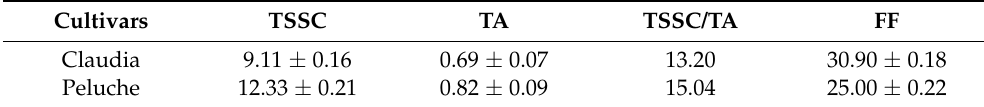
Table 2. Values of TSSC (total soluble solids content, Brix); TA (titratable acidity, g L − 1 malic acid); TSSC/TA ratio; FF (firmness; N) measured on both cultivars. Values represented as mean ± SD.